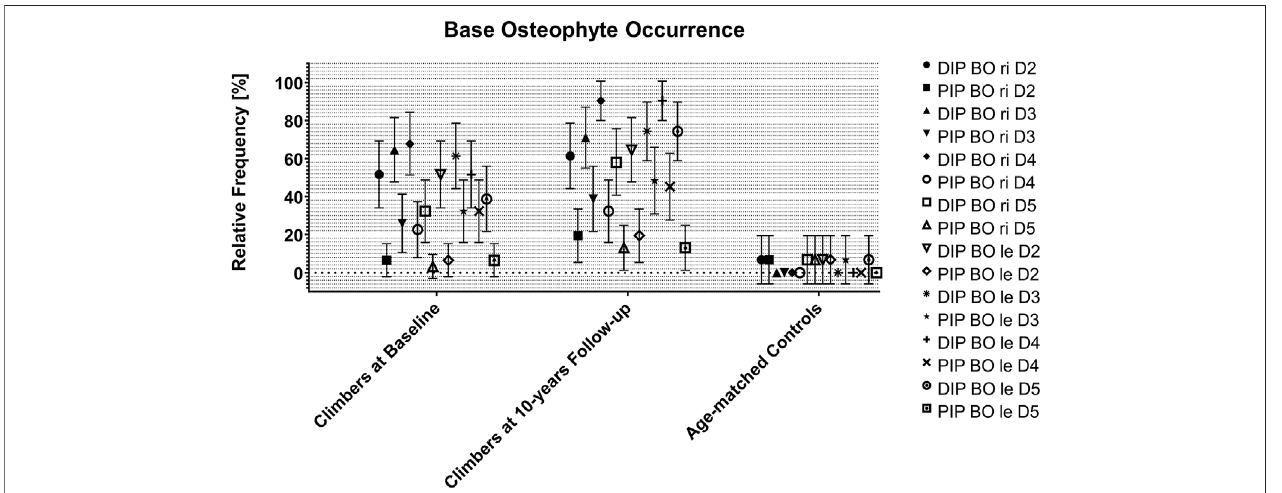
FIGURE 2 | Base osteophyte occurrence in climbers at baseline and at 10 years follow-up, as well as in their age-matched controls. Data are expressed as joint, sideanddigit-speci fi crelativeproportiongroupmeanswith95%CI.BO:baseosteophyte;DIP:distalinterphalangealjoint;PIP:proximalinterphalangealjoint;ri:right;le: left; D: